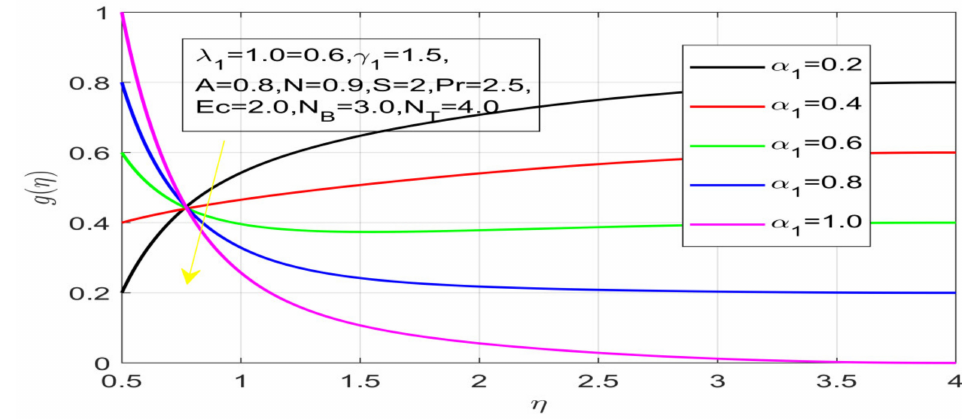
Figure 8. Influence of α _1 on azimuthal velocity.